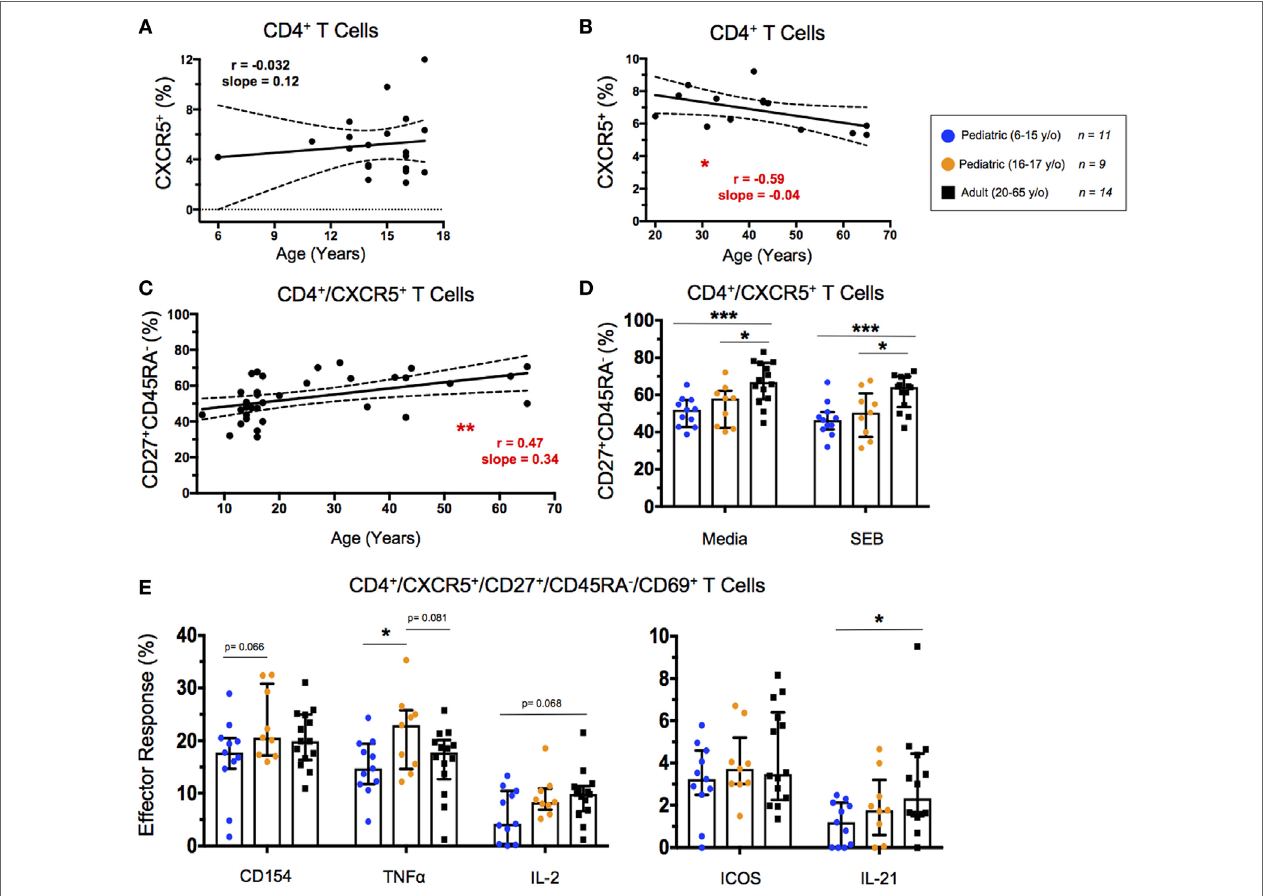
FigUre 5 | Circulating T follicular helper (cT FH ) cell response. (a,B) Line graphs represent linear regression with 95% confidence intervals among baseline CD4 + CXCR5 + T cells in children between 6 and 17 years old ( n = 20) and adults between 20 and 65 years old ( n = 14). (c) Line graph represents linear regression with 95% confidence intervals among CD4 + CXCR5 + CD27 + CD45RA − effector cT FH in all volunteers ( n = 34) between 6 and 65 years old. Line graph statistics were analyzed by Spearman r correlation (* p < 0.05; ** p < 0.01). (D) Scatter plots showing percent effector cT FH under both unstimulated (media) and SEB stimulated conditions. (e) Scatter plots showing net percentages of effector cT FH producing CD154 (CD40L), TNF- α , IL-2, ICOS, and IL-21. Populations are shown for 6–15-year-old pediatric ( n = 11), 16–17-year-old pediatric ( n = 9) and adult ( n = 14) participants. Bars represent medians with whiskers indicating interquartile ranges. Scatter plot statistics were analyzed by unpaired t -test (* p < 0.05; *** p <